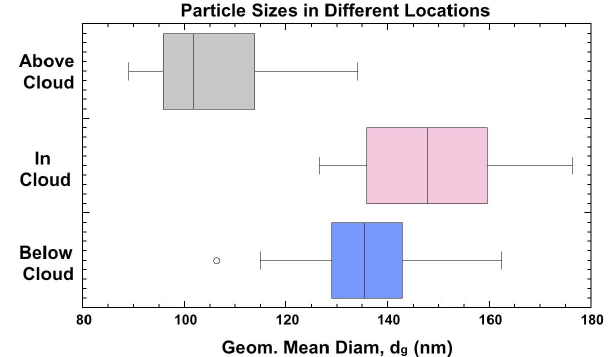
Fig. 9. Statistics of UHSAS geometric mean diameter for 20 pairs of below-cloud aerosol particles (blue) and CVI droplet residual nuclei (pink) in VOCALS clouds with drizzle < 5L − 1 and ratio of CVI total number concentration to droplet number concentration < 1. Seventeen above-cloud samples are also shown in grey. The box limits represent the upper and lower quartiles, with the median as a vertical line. The lines extending from the left and right of each box mark the maximum and minimum values within the data set that are within the upper quartile + (1.5 × the interquartile distance) or less than the lower quartile – (1.5 × the interquartile distance), respectively. Outliers are marked with